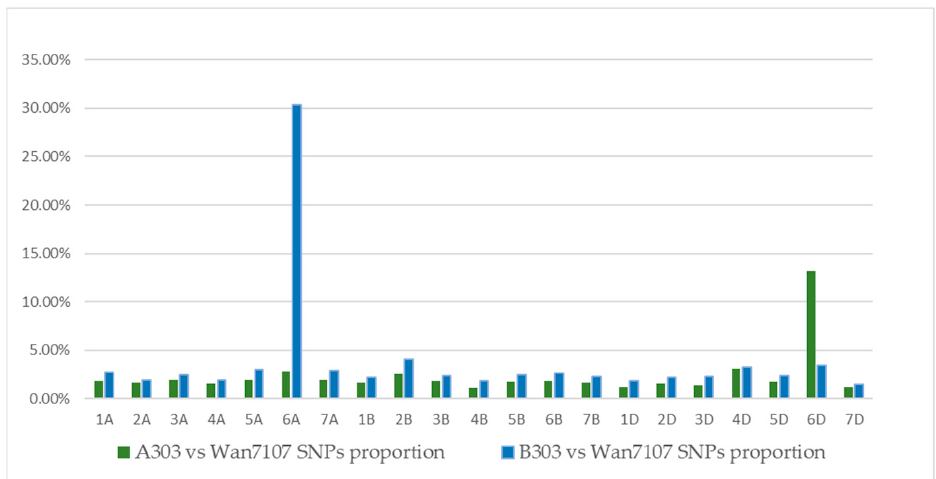
Figure 4 . Schematic diagram of the percentage of SNPs between two translocation lines and Wan7107 on each chromosome .